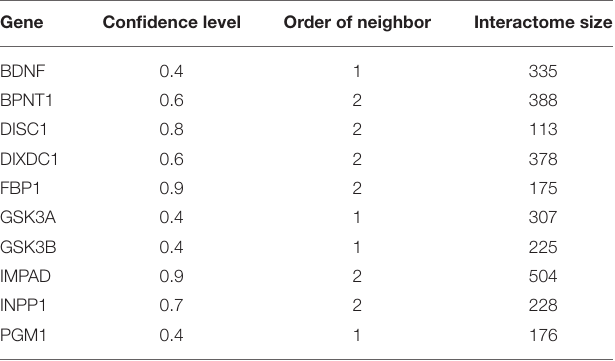
TABLE 1 | Interactome parameters and sizes for lithium-sensitive genes.